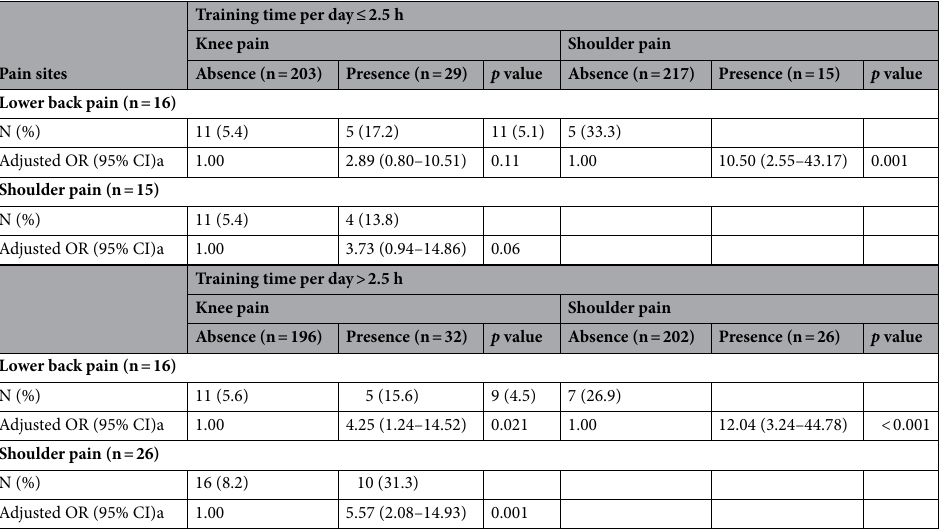
Table 5. Association between lumber pain, knee pain and shoulder pain broken down by 2.5 h per day. OR odds ratio, CI confidence intervals. a Adjusted for gender (male or female), age (7–8, 9–10 or 11–12 years), BMI (body mass index), badminton experience (< 1, 1 to < 3 or ≥ 3 years), h per day (≤ 2.5, or > 2.5 h), days per week (≤ 3, 4–5, or 6–7 days), total h per week (≤ 11, or > 11 h), warming up (yes or no) and cool down (yes or